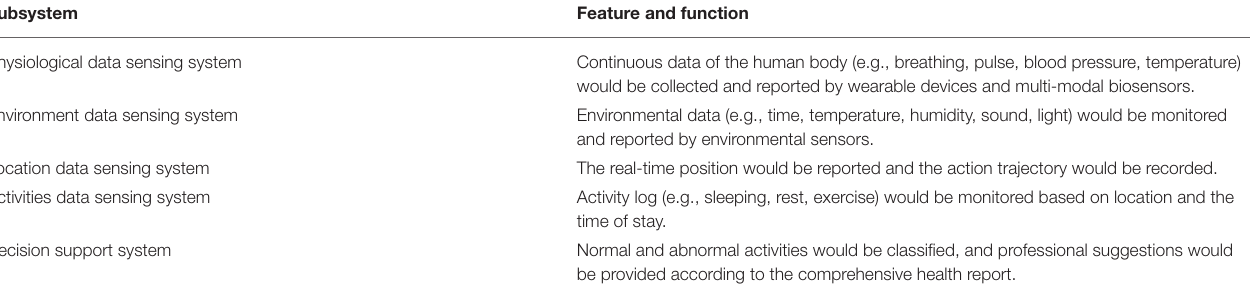
TABLE 1 | User portal (Smart Aged Care Platform) feature